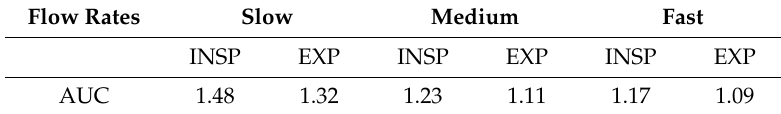
Table 1. Area under the curve (AUC) (in volt-seconds) calculated from variation in the output voltage ( V OUT ) signal for slow, medium and fast inspirations and expirations using the 3-L calibration-syringe. EXP: expiration; INSP: inspiration.